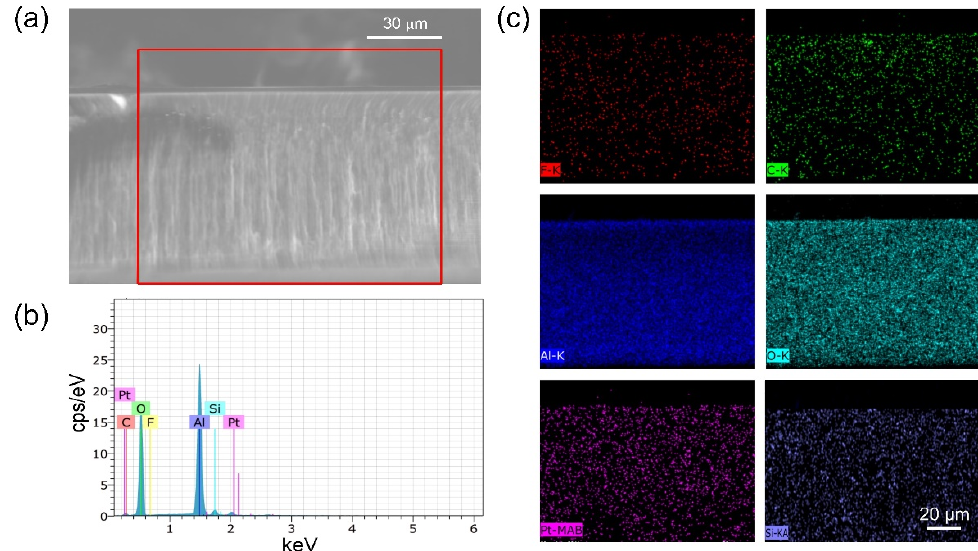
Figure 9. ( a ) Cross-sectional SEM image of the AAO nano-channels filled with PtTFPP molecule. ( b ) EDS spectra revealing Al, O, C, Pt, Si and F peak separately. ( c ) EDS mapping on the area marked by the red square in ( a ).